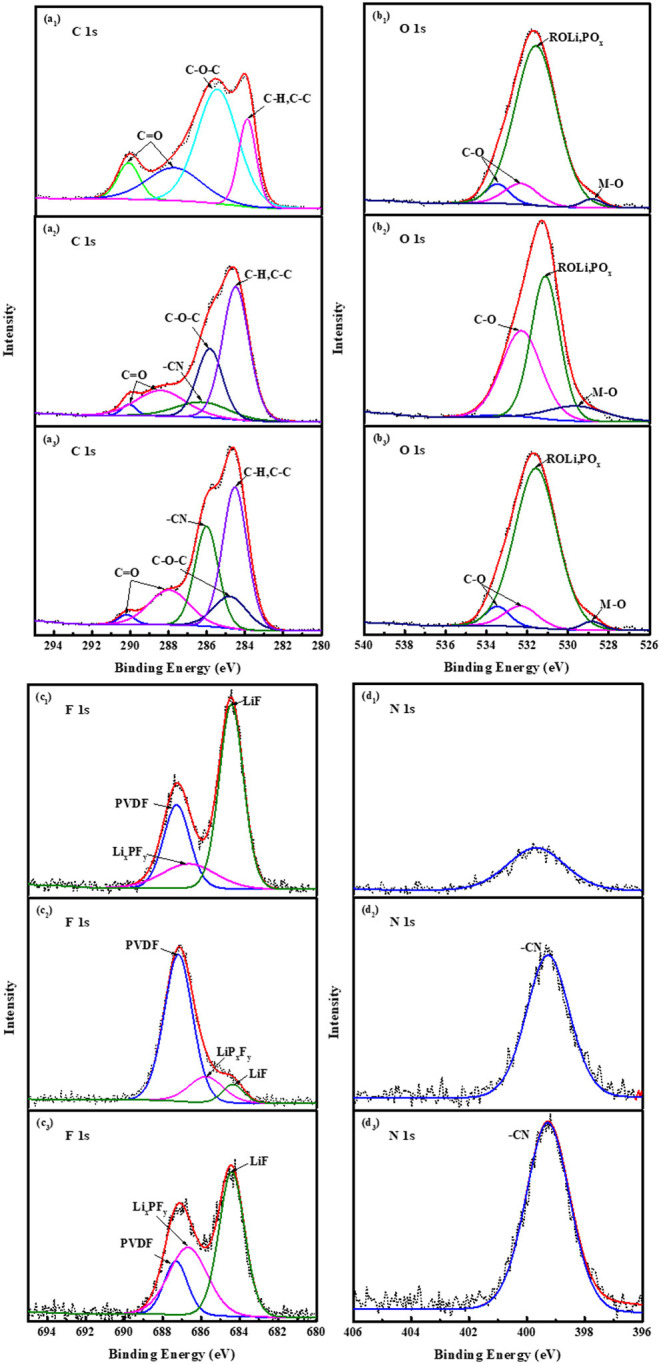
XPS spectra of LiNi0.5Mn1.5O4 cathodes of C 1s, O 1s, F 1s and N 1s with three electrolyte after 20 cycles: (a1-d1) 1 mol L−1 LiPF6-EC/EMC; (a2-d2) 2 mol L−1 LiBF4-GBL/ADN; (a3-d3) 2 mol L−1 LiBF4-GBL/ADN+2%FEC.